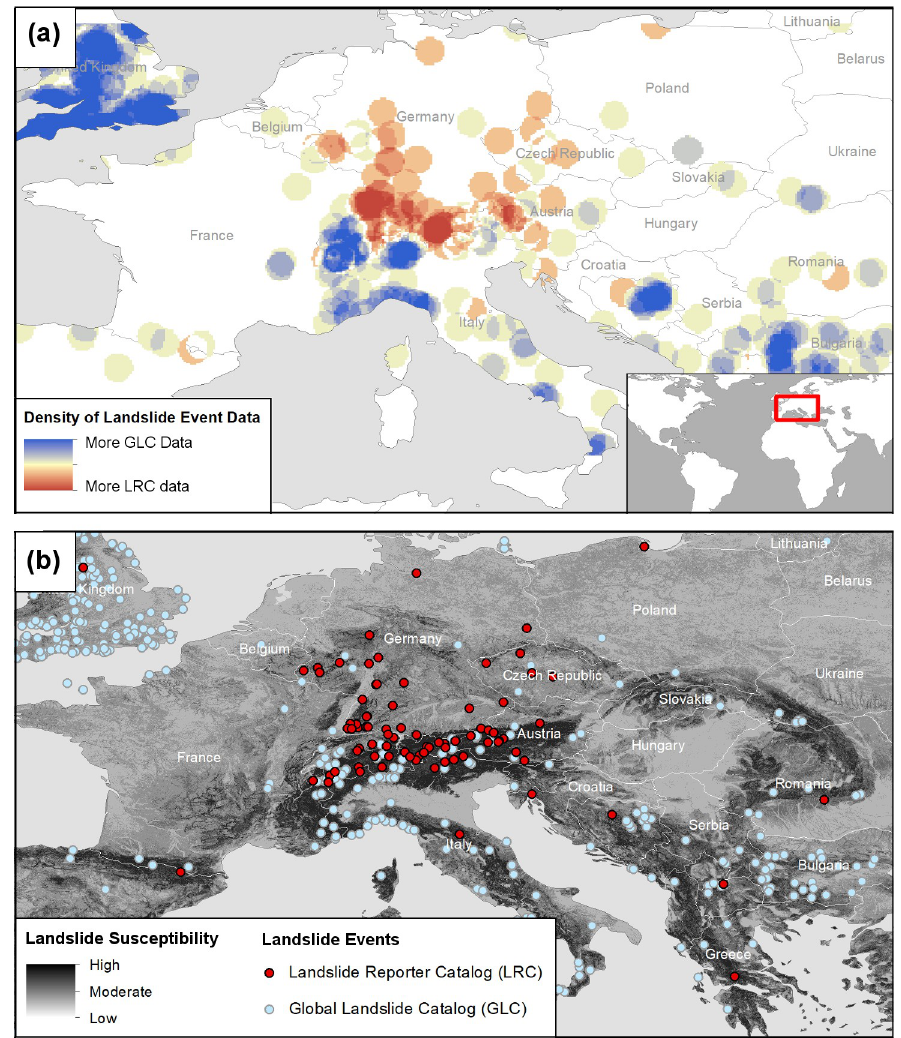
Areas in darker red are dense with LRC landslide events. (b) The map shows LRC events (in red), and GLC events (in light blue) overlaid with the Kirschbaum et al. (2016) [57] landslide susceptibility